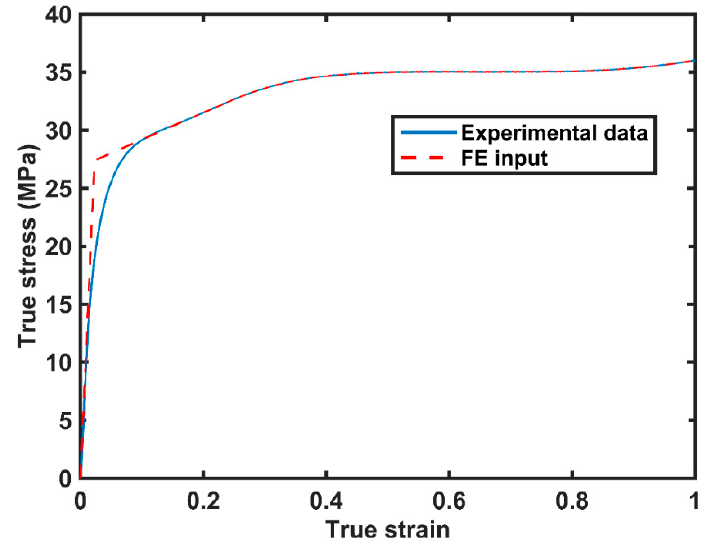
Figure 2. True stress–strain curves obtained by experiment and FE analysis.